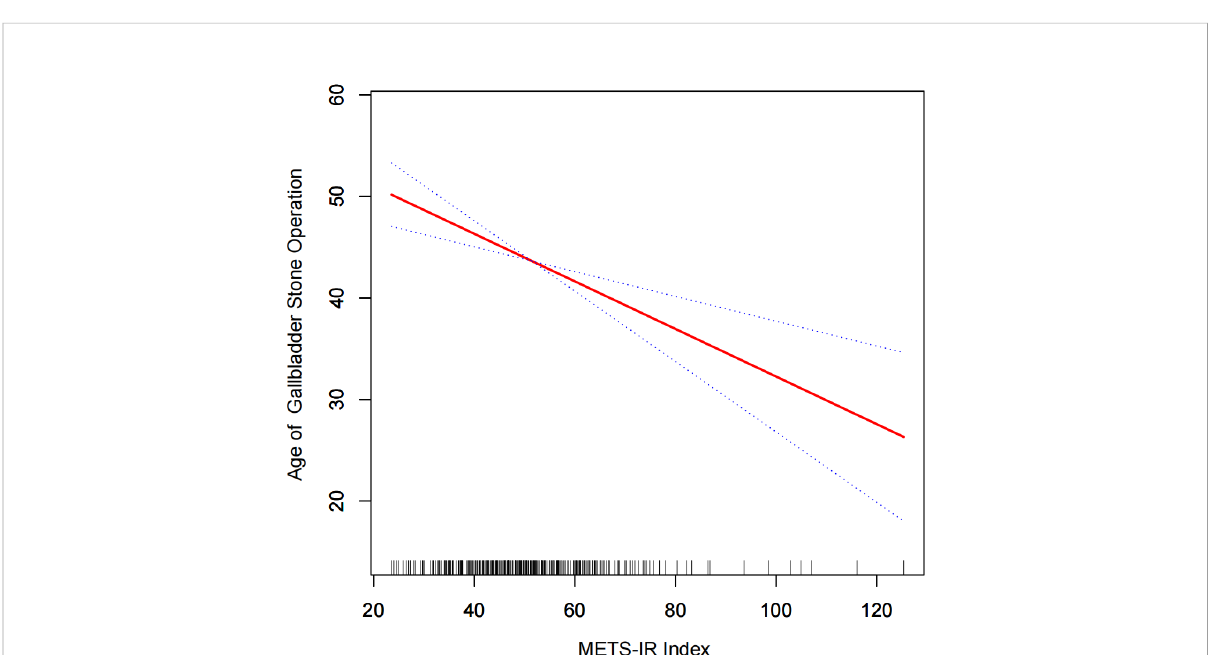
FIGURE 3 Dense dose-response relationship between METS-IR index and age at the time of fi rst gallbladder stone surgery. The area between the upper and lower dashed lines is indicated as the 95% CI. the red line is connected by the magnitude of the METS-IR index into a continuous line. Adjustments were made for all covariates except for effect modi fi